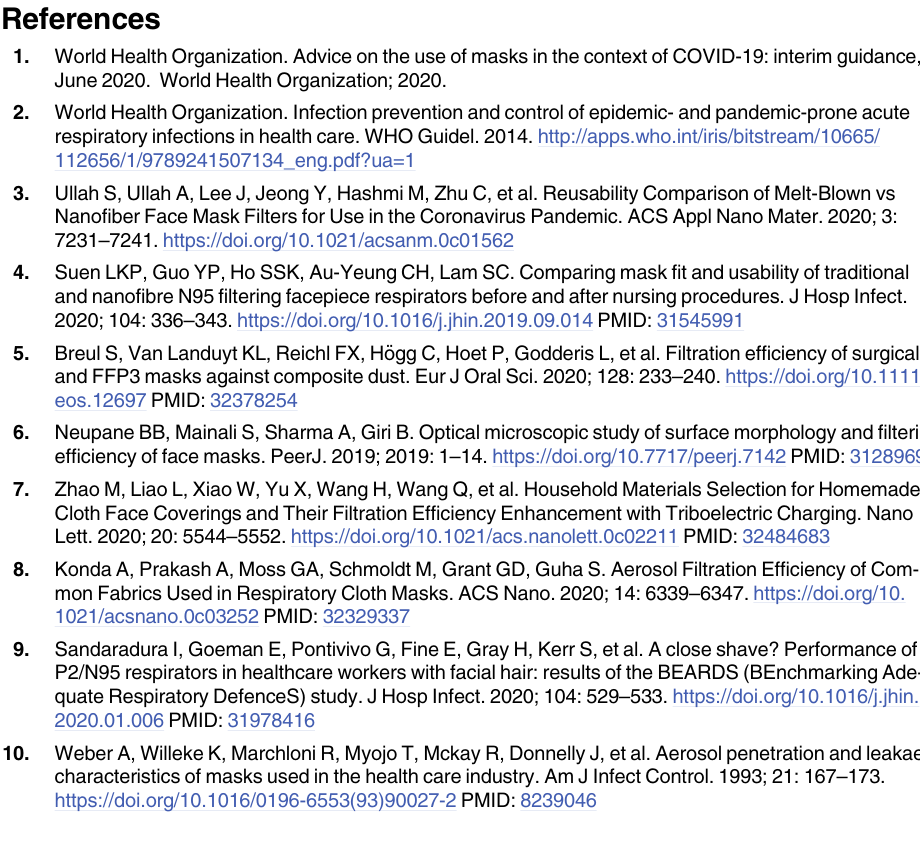
S2 Fig. Filtration ratios of single-sided gap, double-sided gaps, and analytical result. For (a) 3M 1860 and (b) 3M 1870+ masks. (TIF) S3 Fig. Representative pressure distribution diagram. For (a) W (b) W = 0.0463 m. With σ = W mouth (TIF) S1 Data.